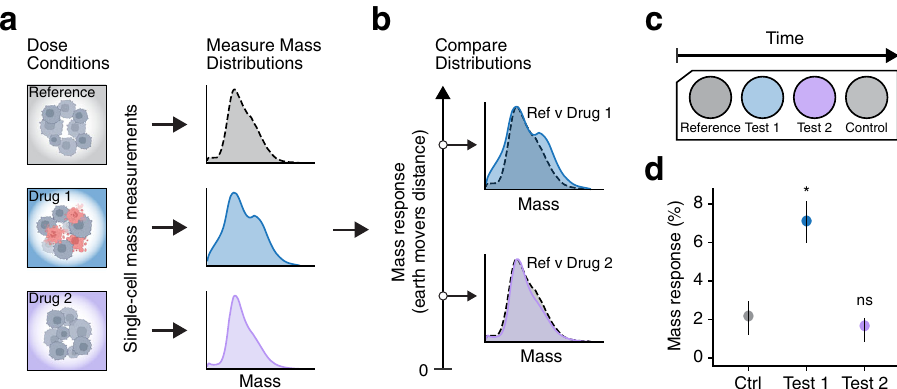
Fig. 2 Measuring the mass response of cancer cells to treatment. a First, isolated cancer cells are dosed and incubated with drugs to be tested (blue and purple) or vehicle-treated control (gray). The mass of individual cells from each population are measured by the SMR instrument to determine the mass distribution of treated cells (blue and purple curves) and untreated reference cells (gray curve). b Mass distributions of the treated and reference cells are compared to determine the mass response to treatment. The mass response signal is the statistical distance between the two mass distributions calculated by the Earth Mover ’ s Distance (Methods). Comparing two similar distributions (purple vs gray) yield a smaller mass response signal, whereas comparing diverging distributions (blue vs gray) results in a larger mass response signal. c Schematic representation showing the structure of the mass response test. Vehicle-treated control cells are measured both before and after the cells that are treated with the drugs being tested. This approach enables measuring a baseline mass response signal between two control populations (reference vs control), which captures possible time-varying mass changes due to in vitro effects. d Mass response plot showing the mass response signals of the control and treated cells shown in ( a ) and ( b ). 95% con fi dence intervals, shown as lines overlaid on each point, are calculated by bootstrapping using single-cell mass data (Methods). The p values are determined by comparing the mass response magnitude difference of TEST and CTRL to a “ limit of decision ” threshold of 3% (Methods). * indicates p < 0.05, ns indicates p >